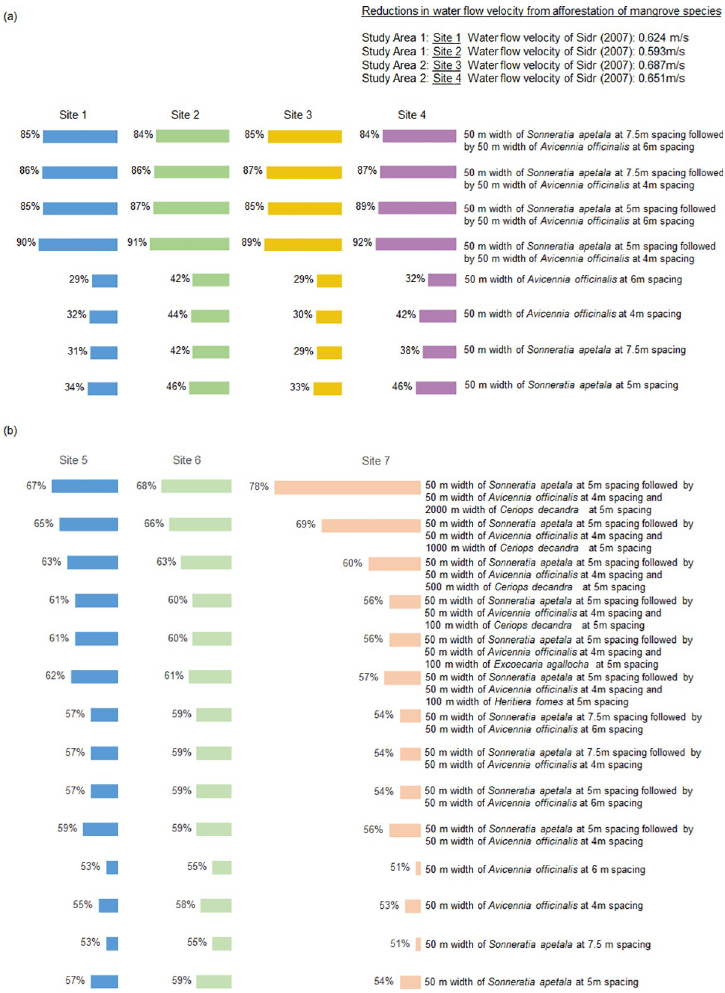
Fig 4. Reductions in Cyclone Sidr water flow velocity (m/s) from afforestation with mangrove species. (a) Study area 1: site 1, 0.624; site 2, 0.593. Study area 2: site 3, 0.687; site 4, 0.651. (b) Study area 3: site 5, 0.618; site 6, 0.987; site 7,